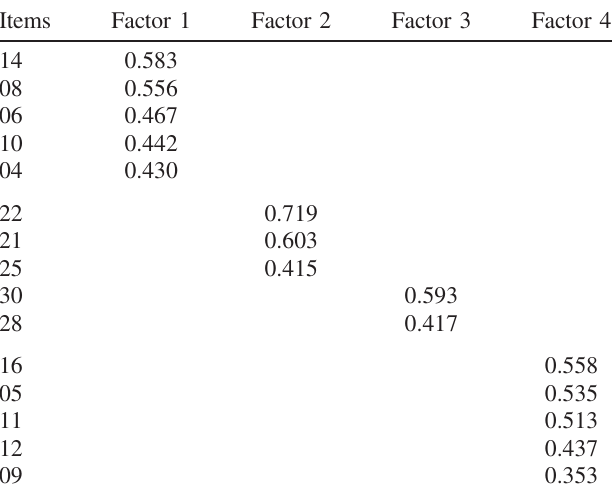
TABLE I. Factor loadings from EFA utilizing the Kaiser criterion. Loadings less than 0.3 have been suppressed. EFA involved all section 1 students. These factors represent factors whose eigenvalues are over unity after other filtering criteria were applied to the original 30 items.